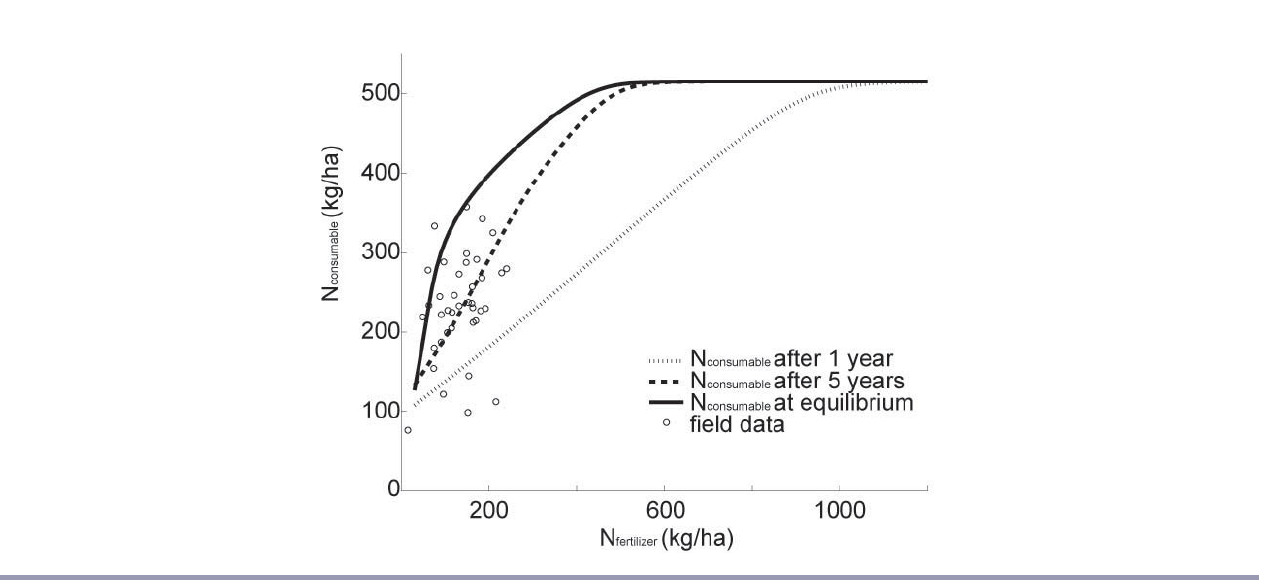
Fig. 6. The change of input-output relation of the consumable part of the plant to external nitrogen input. For a field after years of maize cultivation, the dotted line is the response of the consumable part to fertilizer after 1 year, the dashed line after 5 years, and the solid line when the system has reached equilibrium. The circles are the input-output relation of farms in